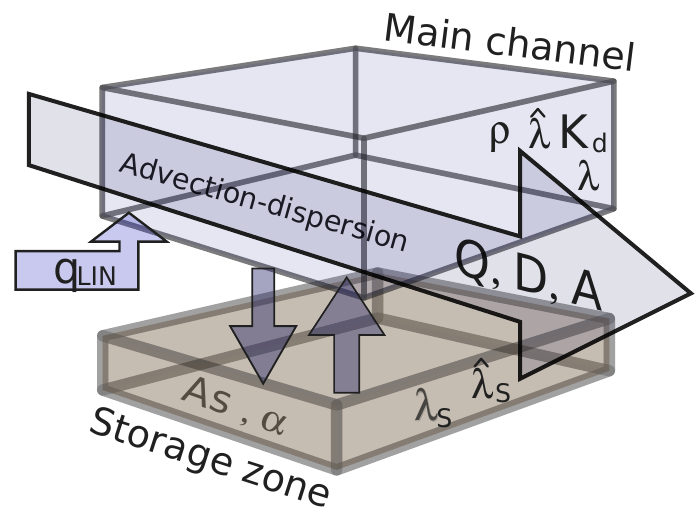
Figure A1. Conceptual mode of OTIS-P. Symbols explained in Appendix